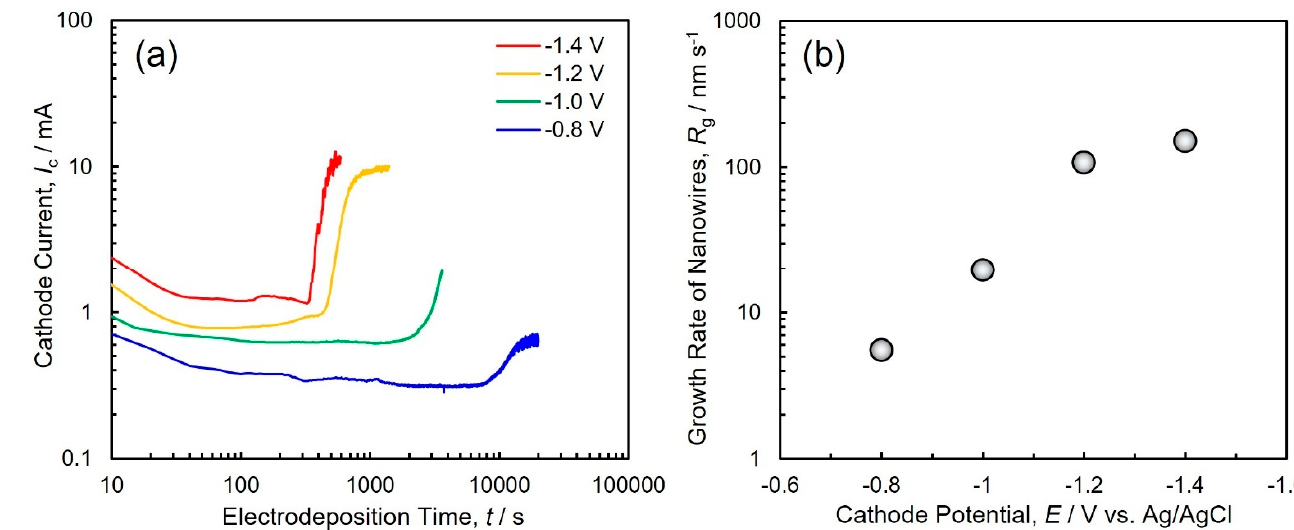
Figure 8. Time dependence of the cathode current during the electrodeposition of ZnTe nanowires in anodized aluminum oxide membranes ( a ). The effect of the cathode potential on the growth rate of ZnTe nanowires in anodized aluminum oxide membranes ( b ).